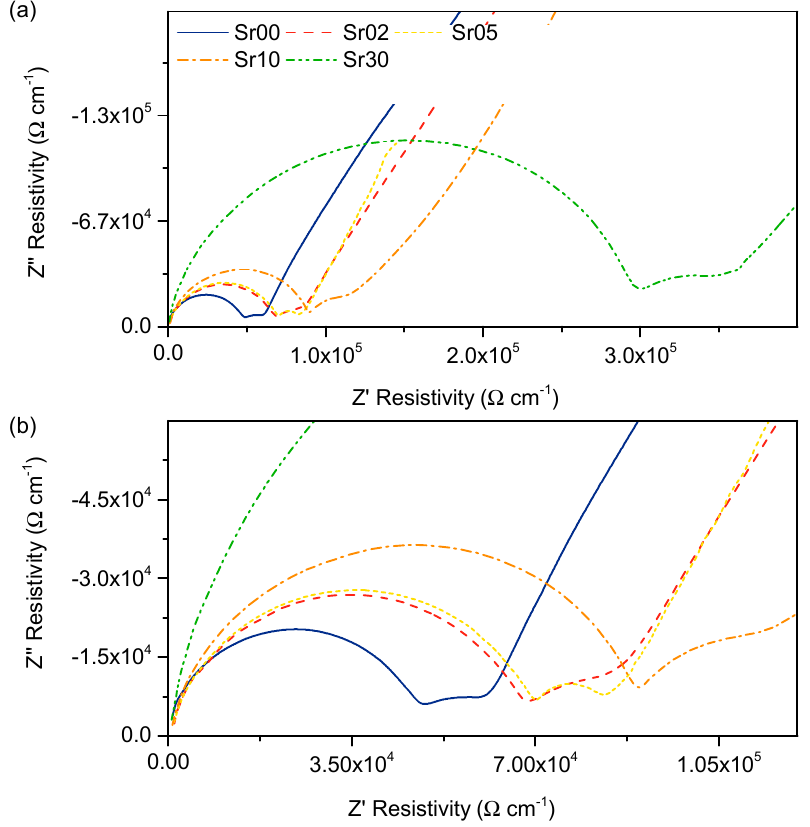
Figure 5. Complete Nyquist plot ( a ) and detail ( b ) showing impedance spectra for Ce 0.8-x Sm 0.2 Sr x O 2- δ samples indicated measured at 250 °C. Data are plotted as resistivities to normalise for variations in sample dimensions.